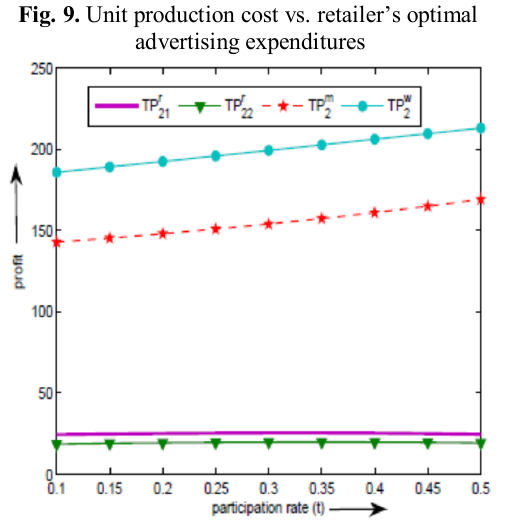
Fig. 9. Unit production cost vs. retailer’s optimal advertising expenditures